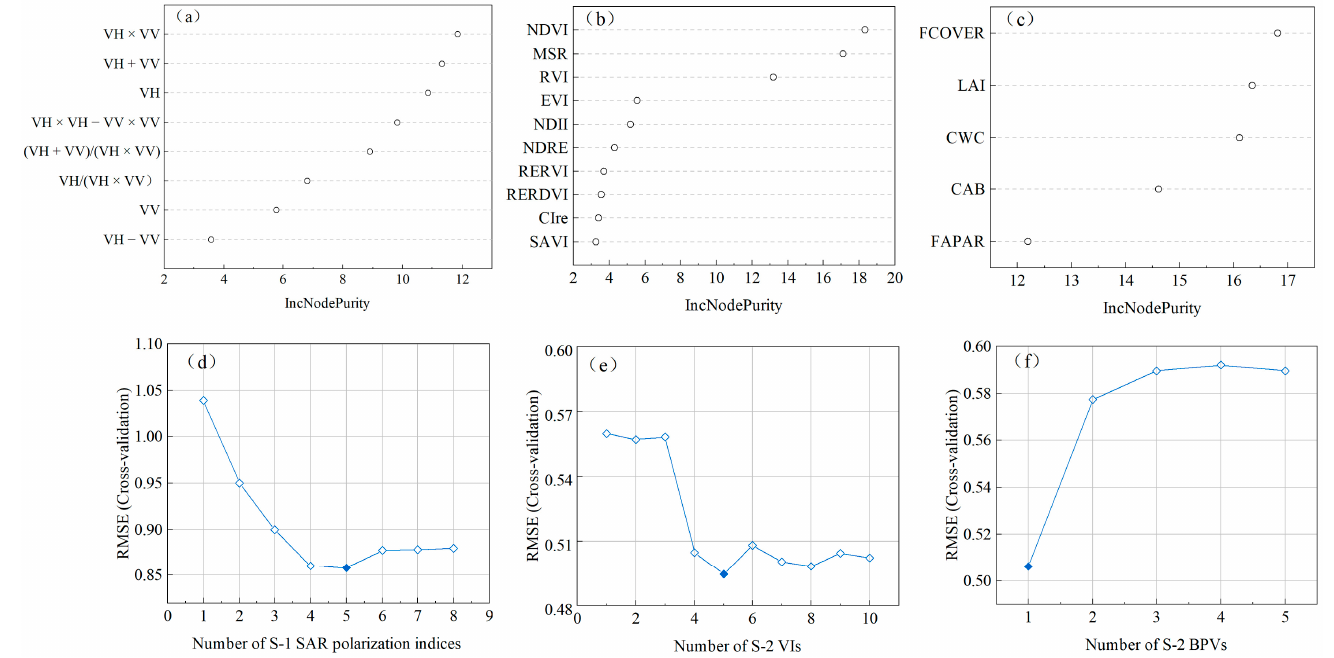
Figure 5. Random forest-based variable importance for ( a ) S-1 SAR polarization indices, ( b ) S-2 VIs, and ( c ) BPVs; selection of optimum number of variables based on the least RMSE for 5-fold cross-validation for ( d ) S-1 SAR polarization indices, ( e ) S-2 VIs, and ( f ) BPVs.